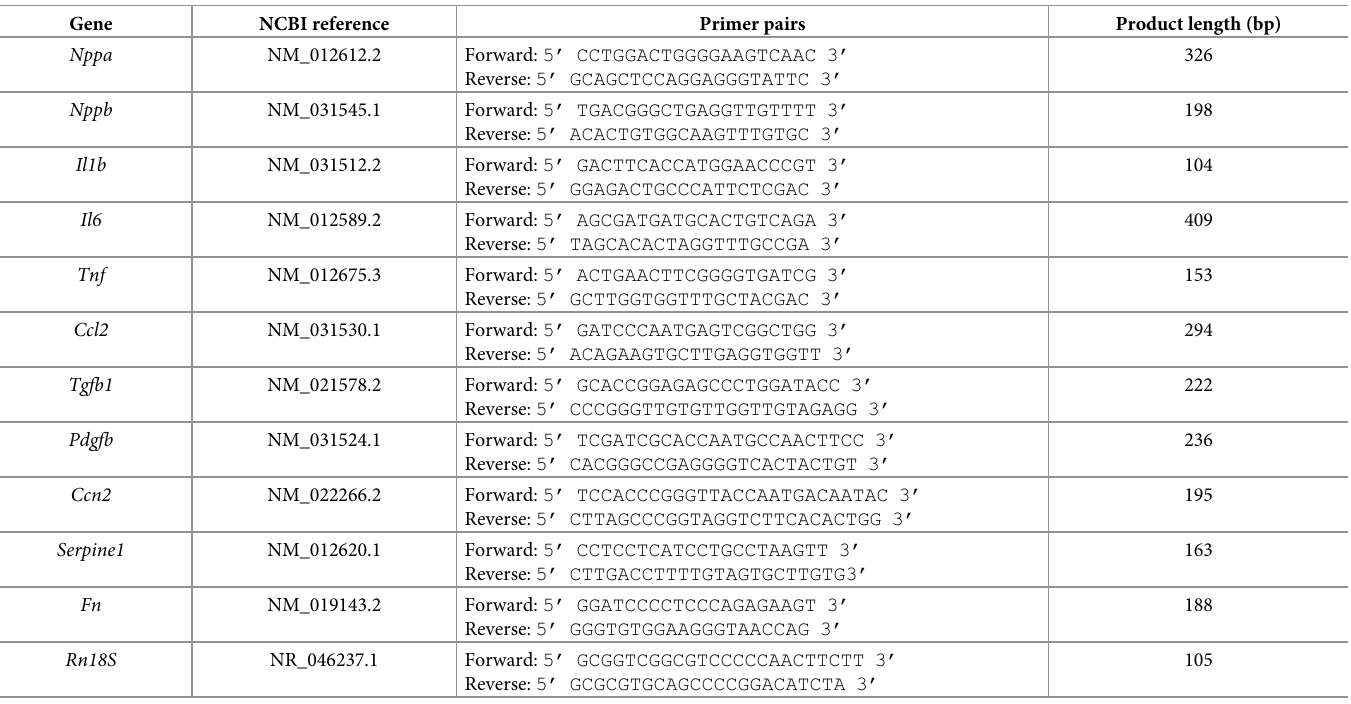
Table 1. Sequences of primer pairs for quantitative